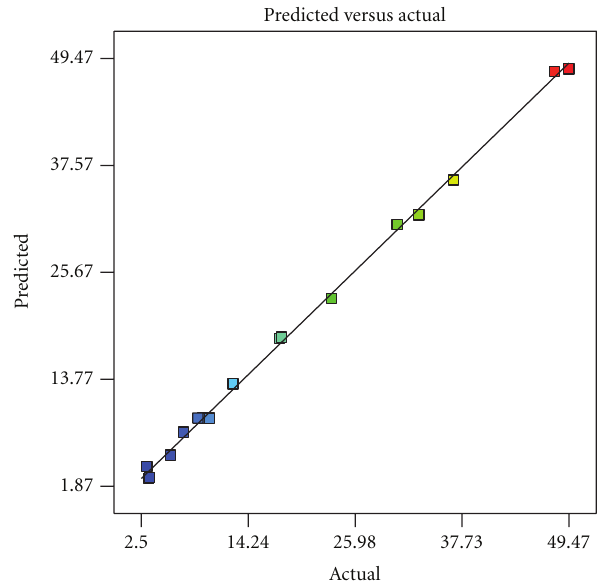
Figure 7: The normal prpbability (%) plot of the experimental results for % BA